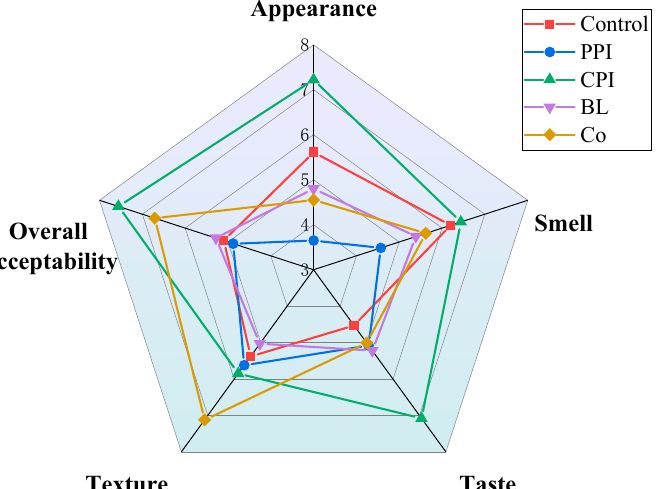
Figure 8. Sensory intensity radar diagram of fish sausage made with soybean oil and various pre-emulsified proteins.